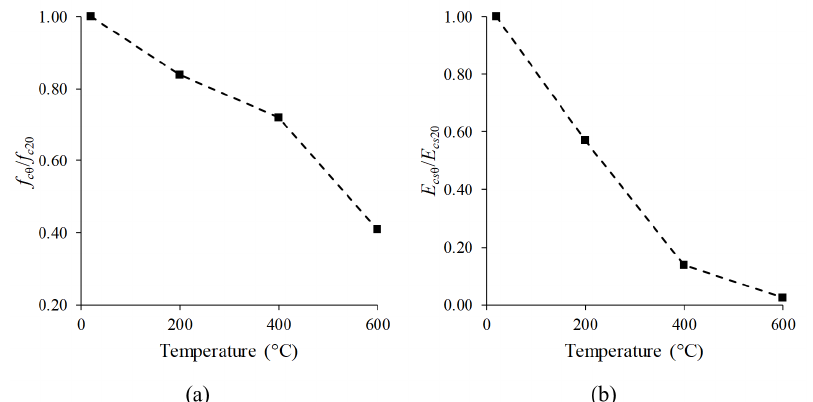
Figure 4. Retention of properties with temperature of exposure: a) compressive strength; b) secant modulus of elasticity.